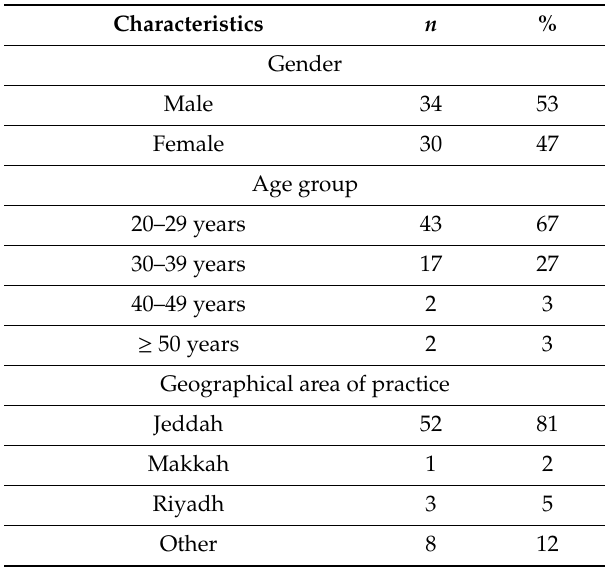
Table 2. Participant